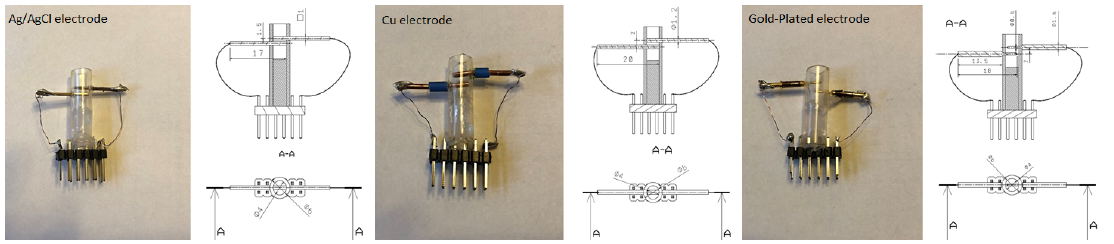
Figure 7. Types of electrodes used in this